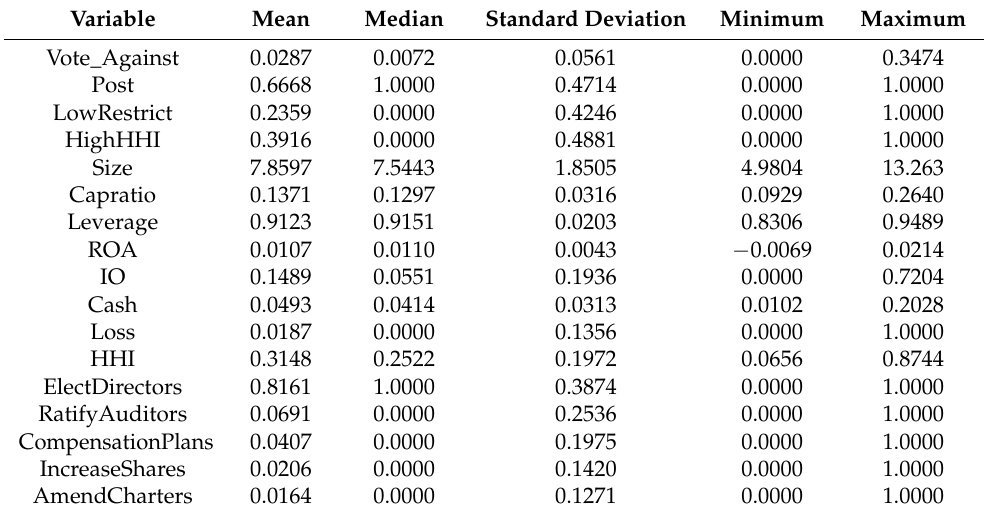
Table 1. Summary